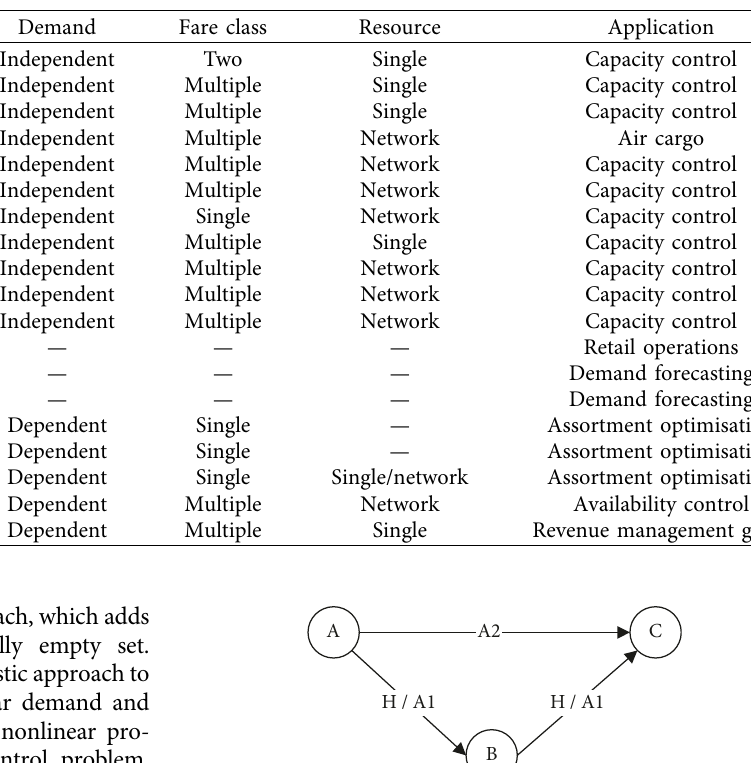
Table 2: Summary of existing research.